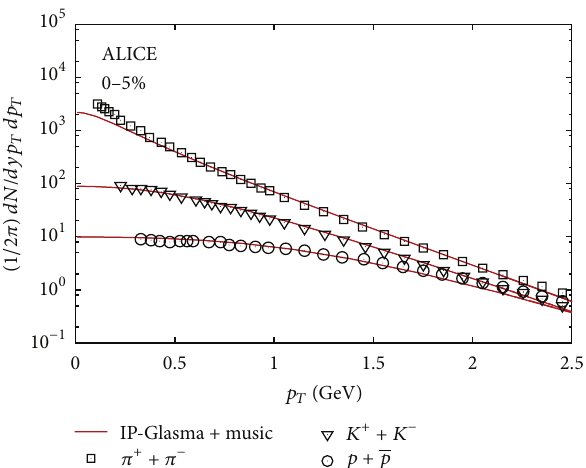
Figure 18: ALICE measurements for the transverse momentum spectra of pion, kaon, and protons in 0–5% Pb+Pb collisions at LHC energy are compared with IP-Glasma model predictions with viscosity over entropy ratio 𝜂/𝑠 = 0.08 . The figures are from [123].